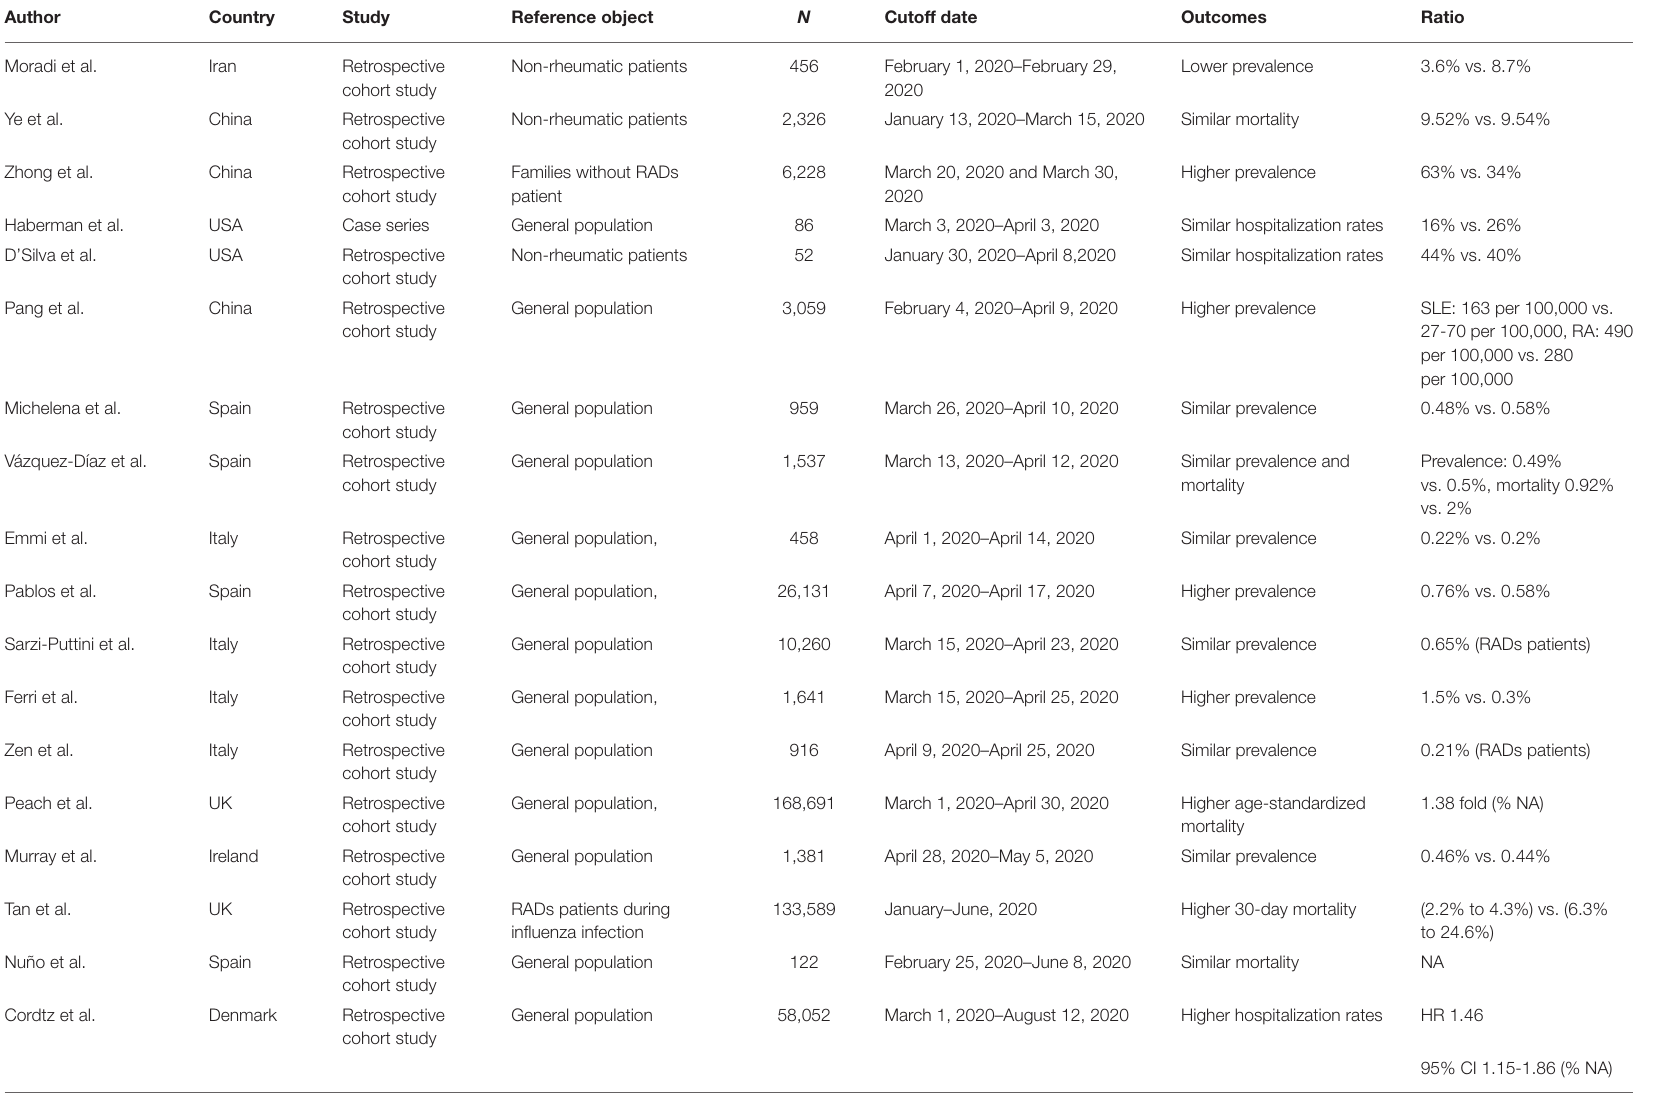
TABLE 1 | The incidence, hospitalization rates, and mortality of COVID-19 in RADs patients in studies from different nations (Shown in Figure 1